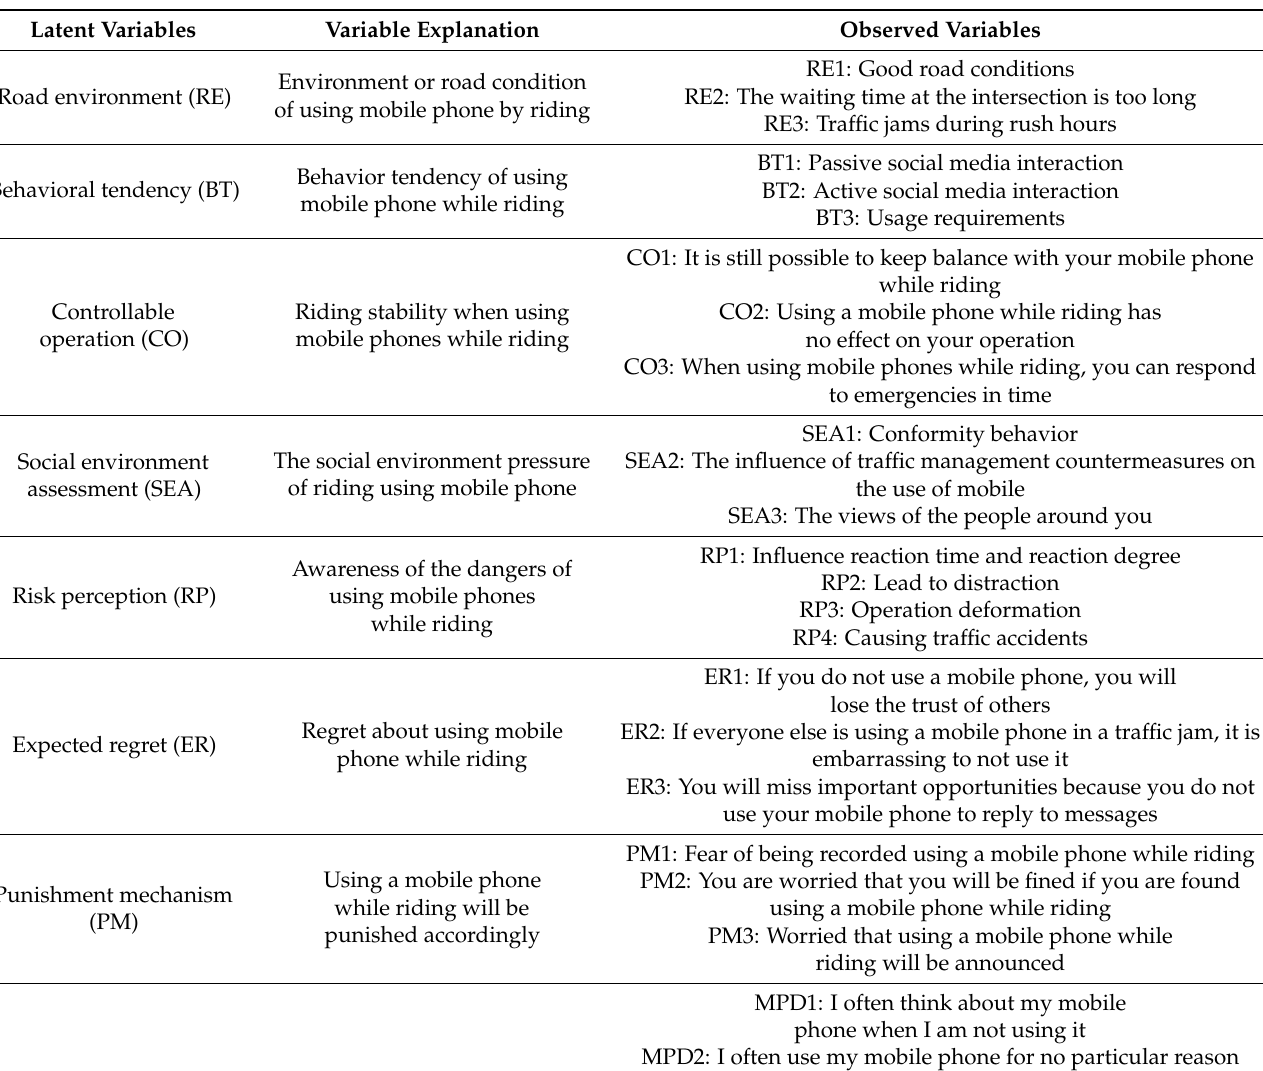
Table 2. Definition and description of latent